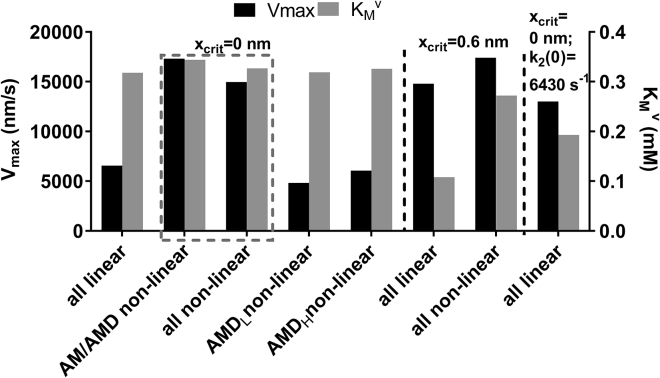
The parameter values Vmax and KMv for actin filament sliding velocity versus [MgATP]. Vmax (black, left axis) and KMv (gray, right axis) were obtained in simulations with different combinations of linear and nonlinear (from (29)) cross-bridge elasticity for different states and force dependence of k2(x) ((xcrit = 0 nm; no force dependence) or (xcrit = 0.6 nm; force dependence)). The final group of parameter values (right) was obtained assuming linear cross-bridge elasticity and ATP-induced detachment rate constant without force dependence, but k2(0) increased almost threefold to 6430 s−1 compared to data in Table S2. The box indicates simulations in which both Vmax and KMv values accord best with experimental data.